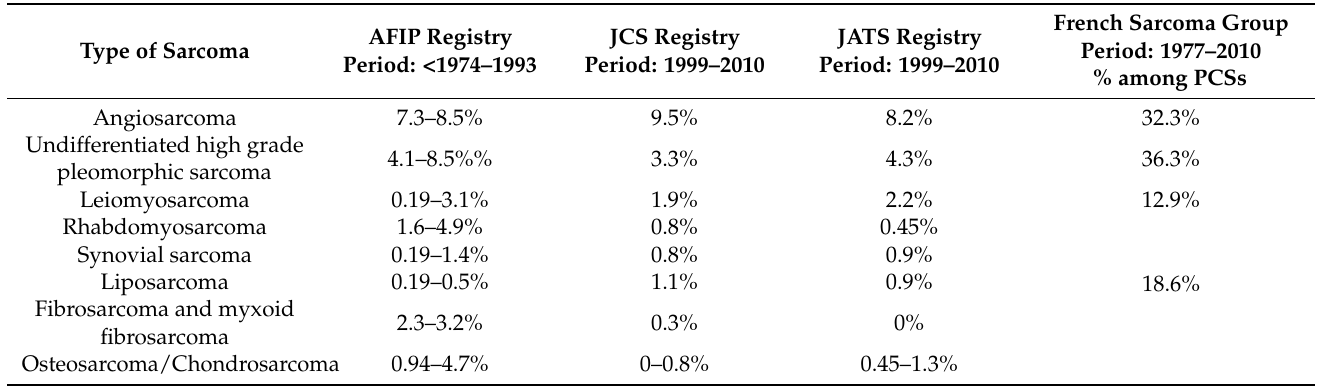
Table 1. Mean incidence in primary cardiac sarcomas among all cardiac tumors according to international registries. Data were from the Armed Forces Institute of Pathology (AIFP), the Japanese Circulation Society (JCS), and the Japanese Association for Thoracic Surgery (JATS) registries [3,17–19]. The French Sarcoma Group registry reported the percentage of patients each kind of sarcoma among all of the primary cardiac sarcomas (PCSs) collected by the group